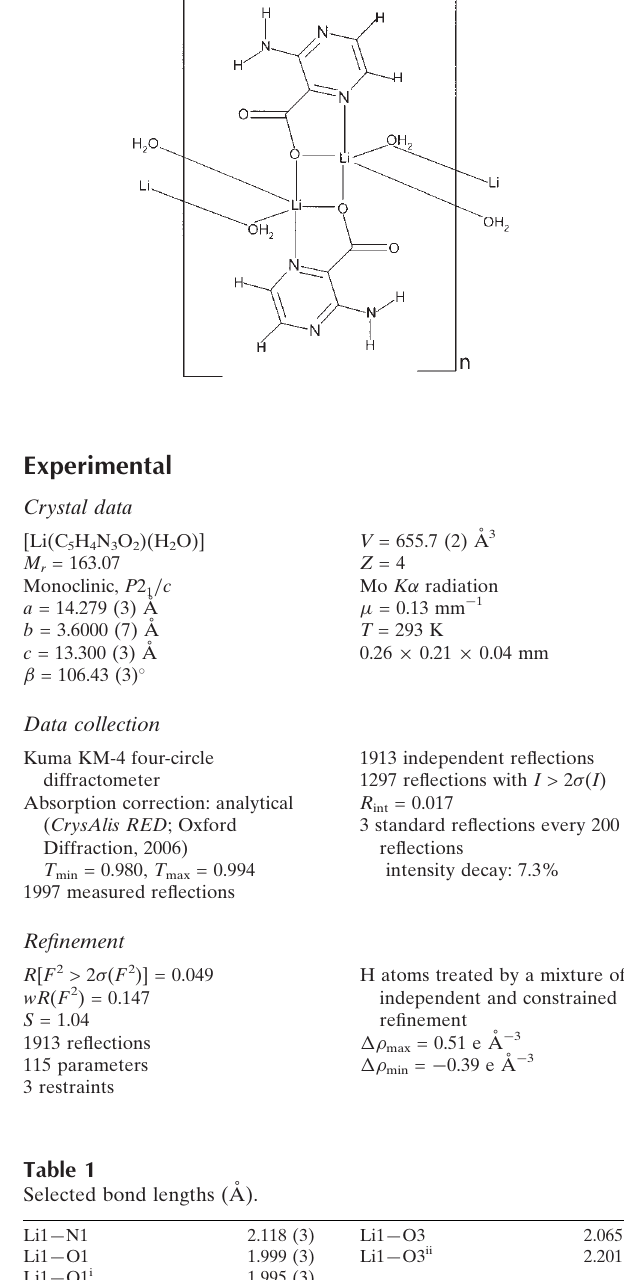
Experimental Crystal data